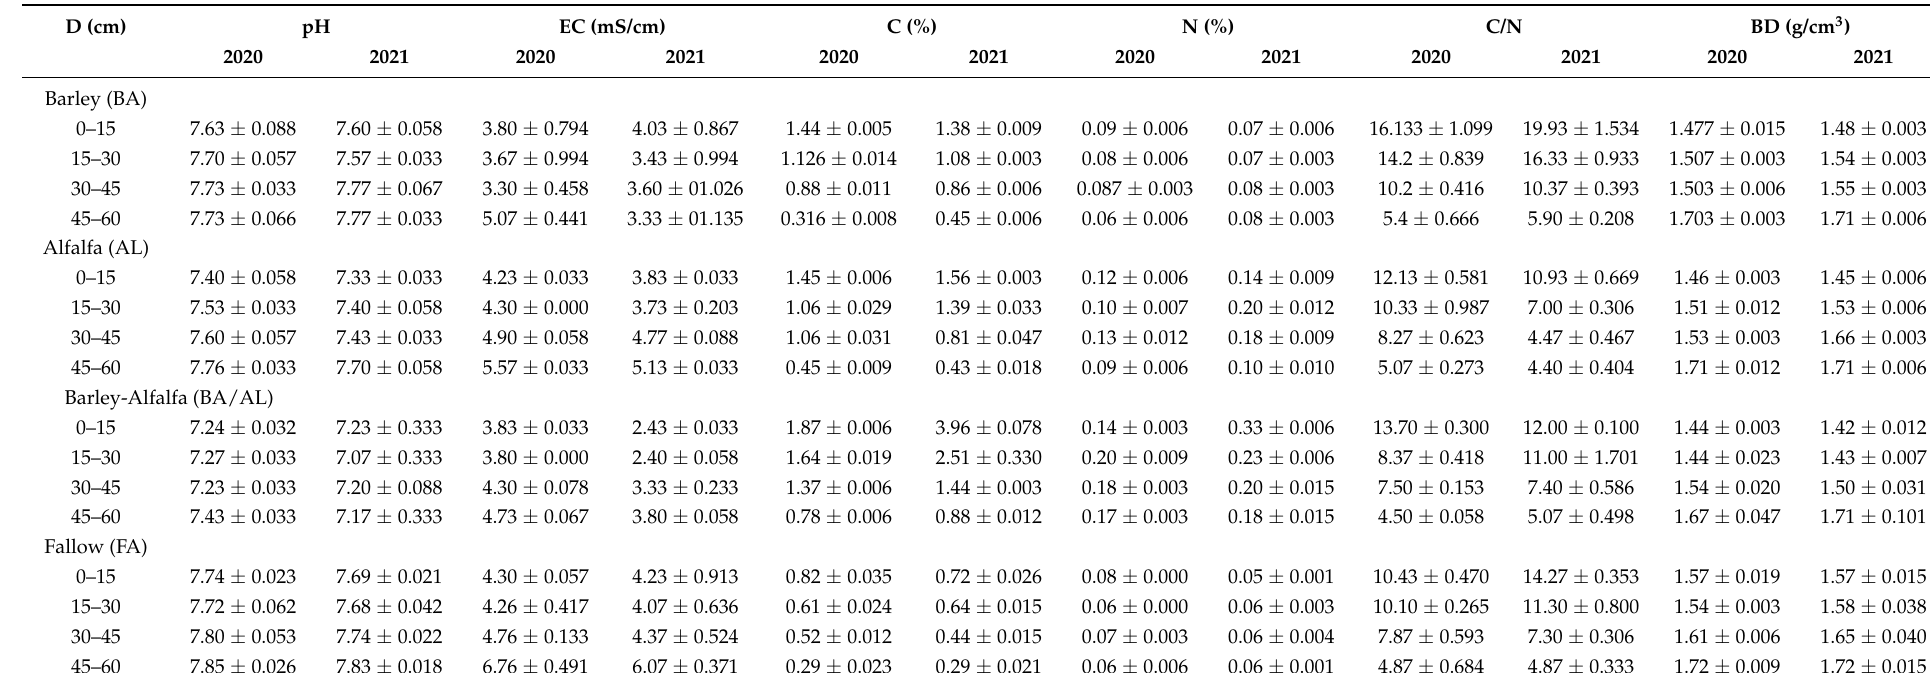
Table 3. Soil properties at the four sub-plots between 2020 and 2021 (n =